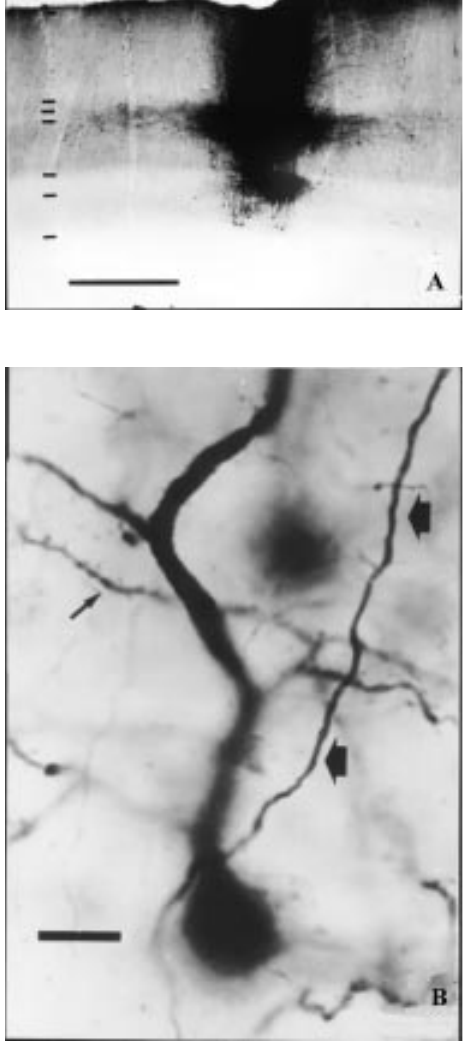
Figure 5 - A , Low power photo- micrograph illustrating antero- grade and retrograde transport near the injection site. Scale bar = 500 µm. B , High power photo- micrograph illustrating in detail a pyramidal cell in infragranular lay- ers. Thick arrows point to an axon. Thin arrow points to spines on dendrite. Scale bar = 10